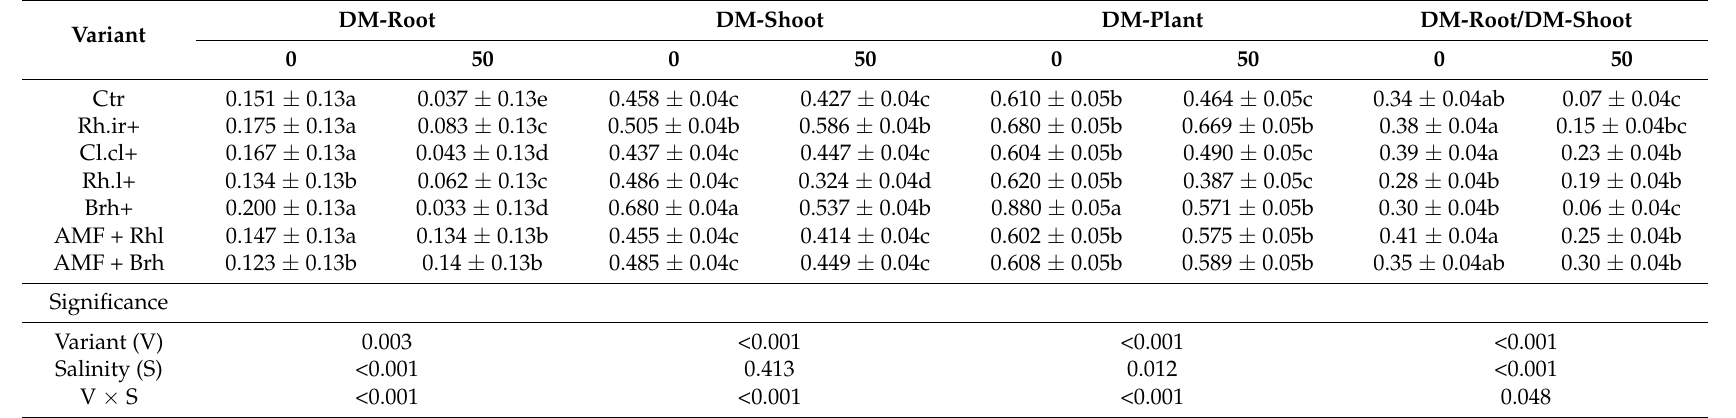
Table 2. Dry matter of roots (DM Root , g plant − 1 ), dry matter of shoot (DM Shoot, g plant − 1 ) dry matter of plant (DM Plant, g plant − 1 ) and DM Root :DM Shoot ratio of control (Ctr), Rhizophagus irregularis —inoculated (Rh.ir+), Claroideoglomus claroideum —inoculated (Cl.cl+), Rhizobium leguminosarum —inoculated (Rh.l+), Burkholderia spp.—inoculated (Brh+), Rhizophagus irregularis + Claroideoglomus claroideum + Rhizobium leguminosarum —inoculated (AMF+Rhl) and Rhizophagus irregularis + Claroideoglomus claroideum + Burkholderia spp.—inoculated (AMF + Brh) pea plants under two levels of salinity (0 and 50 mM NaCl). Different letters indicate significant differences within following parameters (Tukey test, p < 0.05; mean ±